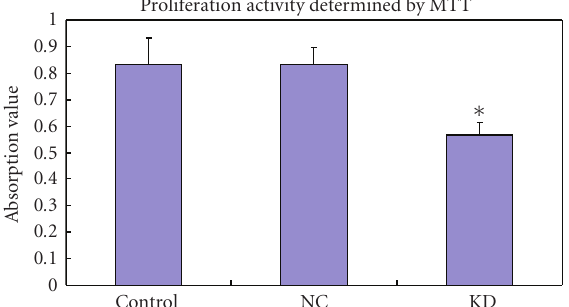
Figure 2: PDE4D regulates PDGF-induced VSMC proliferation. VSMC viability was determined using MTT assay at 48 hours postinfection. Data are mean ± SEM of 3 separate experiments performed in triplicate. ∗ P less than .05 versus control. # P less than .05 versus nonsense